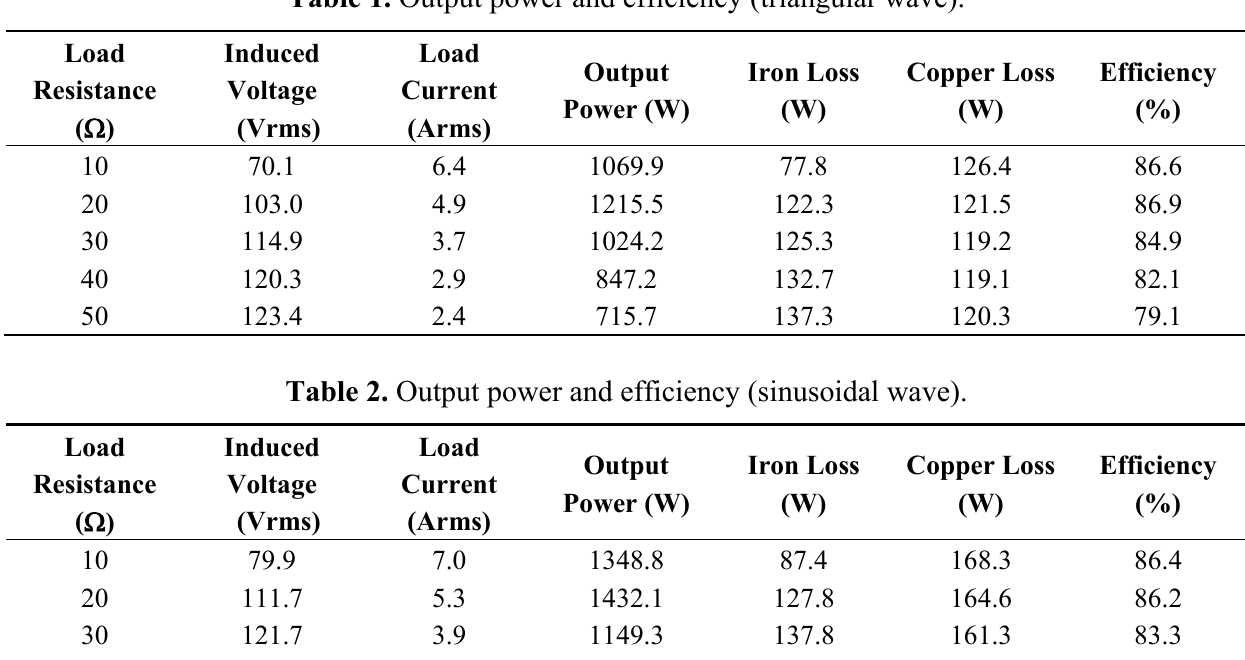
Table 1. Output power and efficiency (triangular wave).